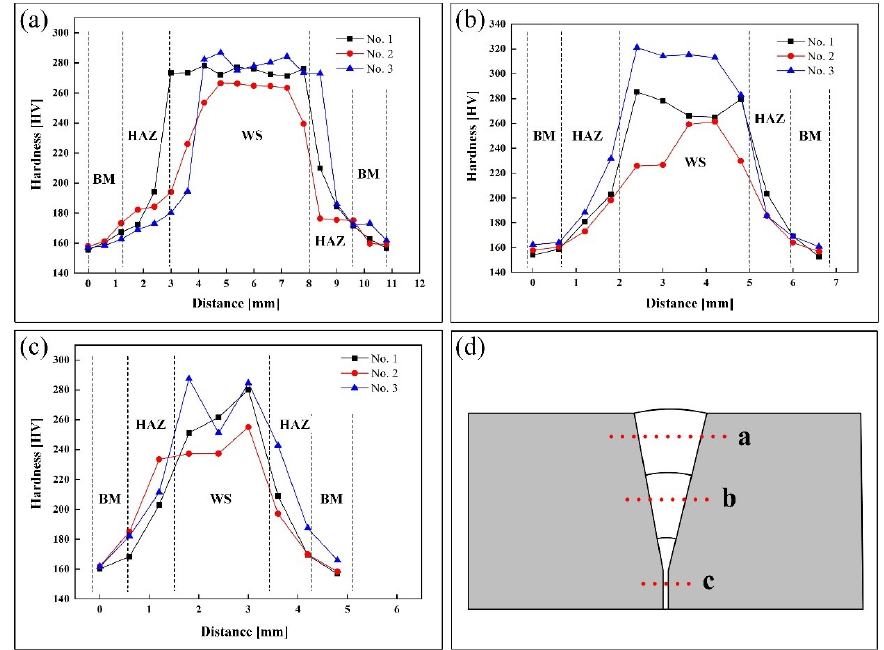
Figure 6. Microhardness test results of specimens: ( a ) the cosmetic weld layer; ( b ) the filling weld layer; ( c ) the backing weld layer; ( d ) microhardness test points of each layer.